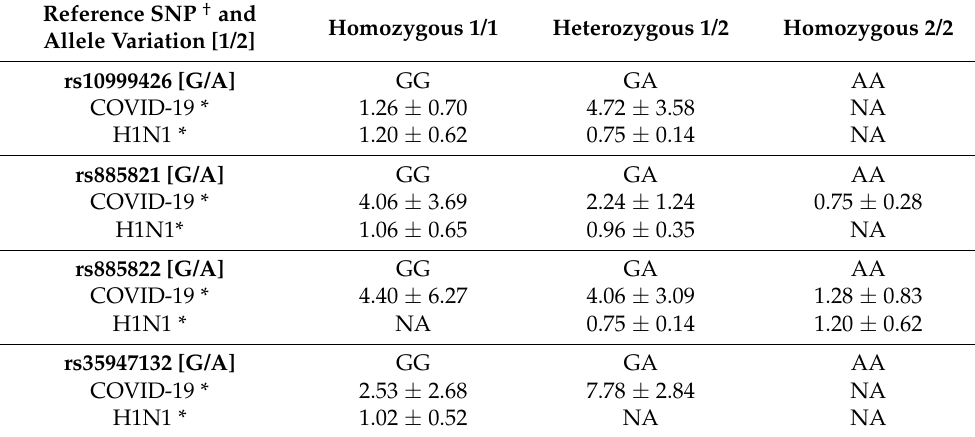
Table 4. Correlation between perforin tissue expression and genotyping in PRF1 gene in COVID-19 and H1N1